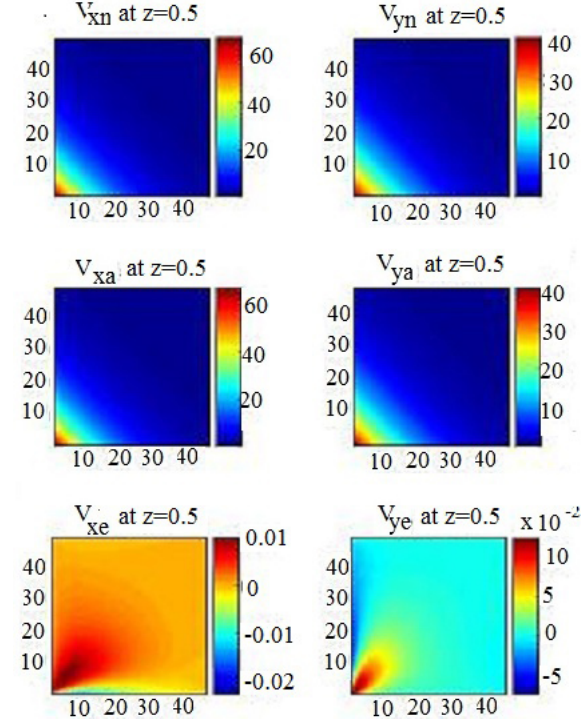
Figure 8. Distribution of v x and v y ; 3-D case, exponentially varying viscosity, high-viscosity contrast ( η 2 = η 3 = η 4 = 100) v xe = v xn − v xa , v ye = v yn − v ya